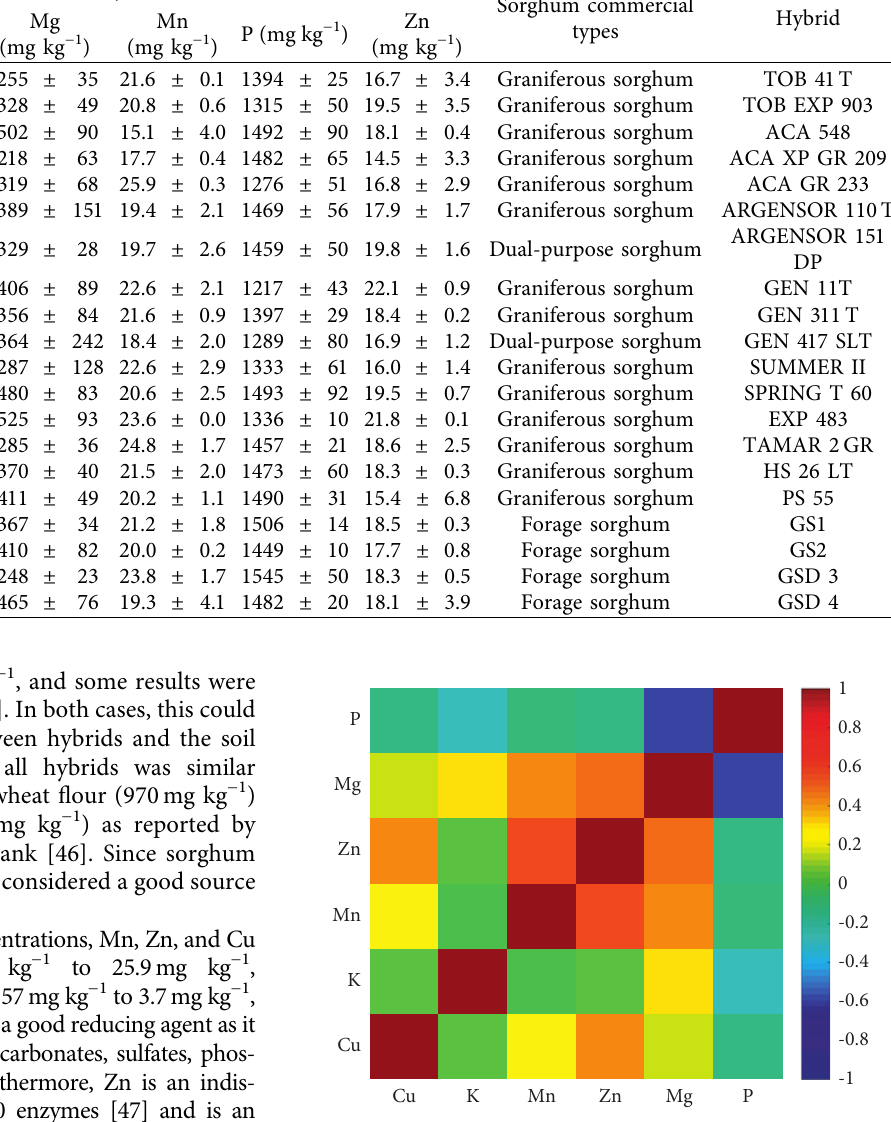
Figure 2: Correlation matrix among variables for the different sorghum genotypes